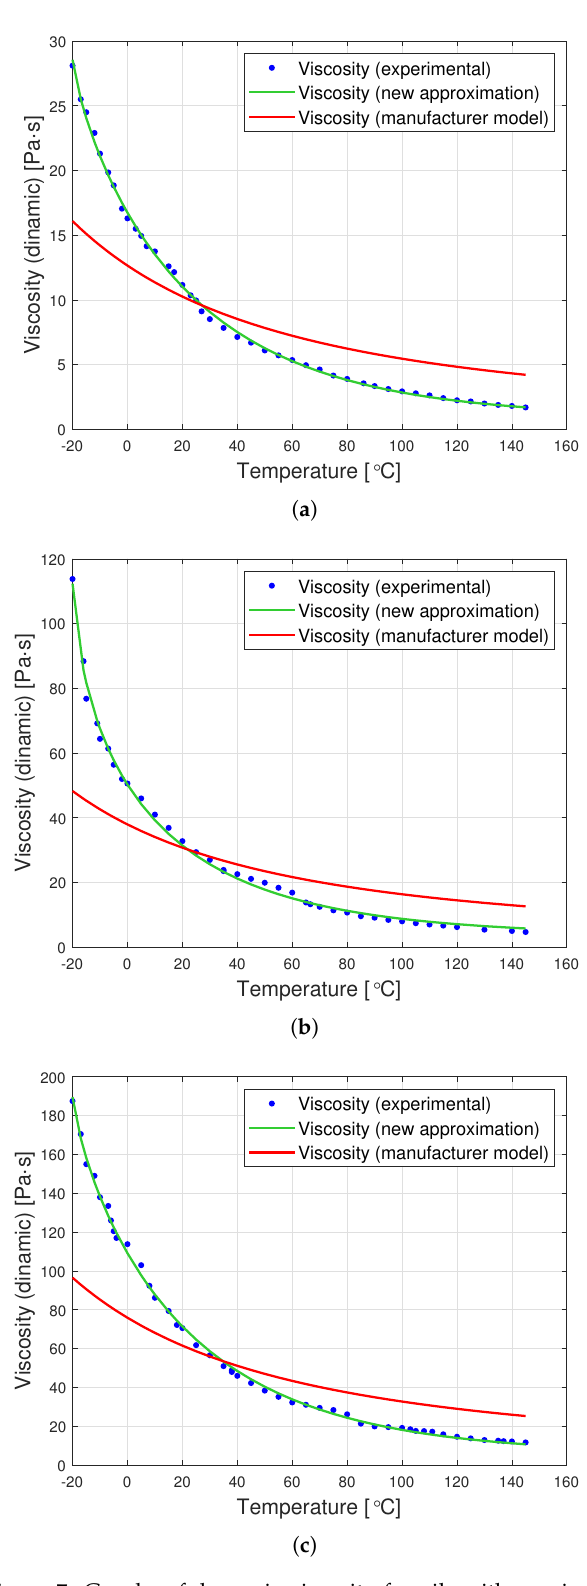
Figure 7. Graphs of dynamic viscosity for oils with nominal kinematic viscosities: ( a ) 10,000cSt, ( b ) 30,000cSt, ( c )